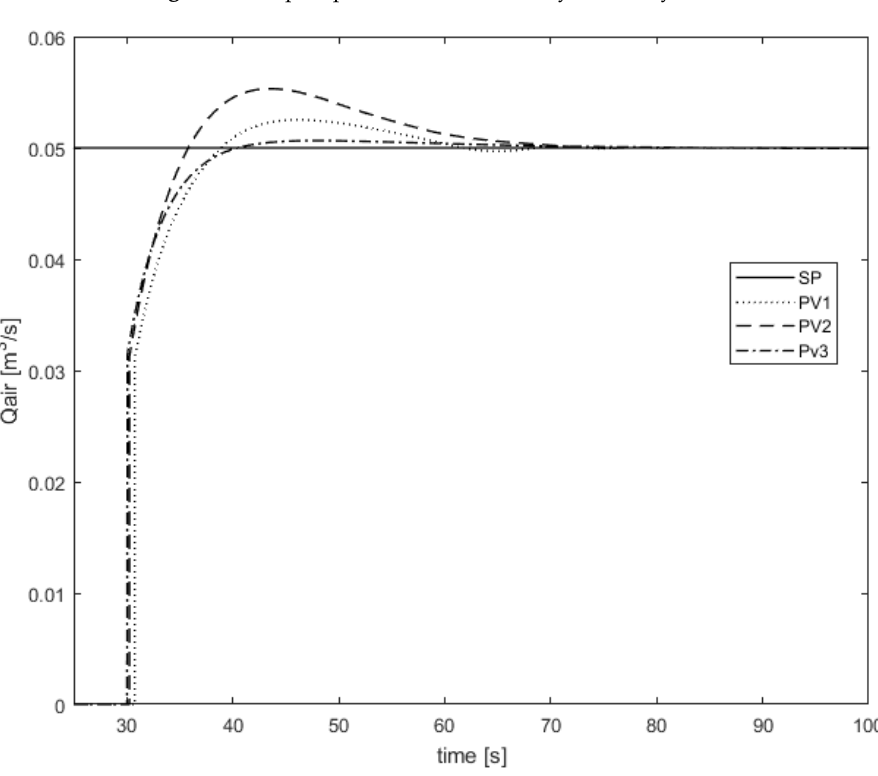
ff erent versions of fuzzy control Figure 12. Comparison of different versions of fuzzy control systems. Figure 12. Comparison of di